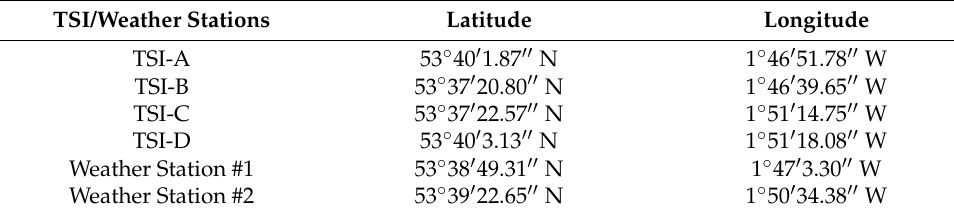
Table 1. Site coordinates.